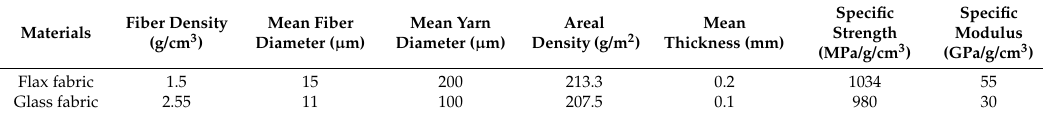
Table 1. The details of fiber fabrics used in manufacturing sandwich structures skins.